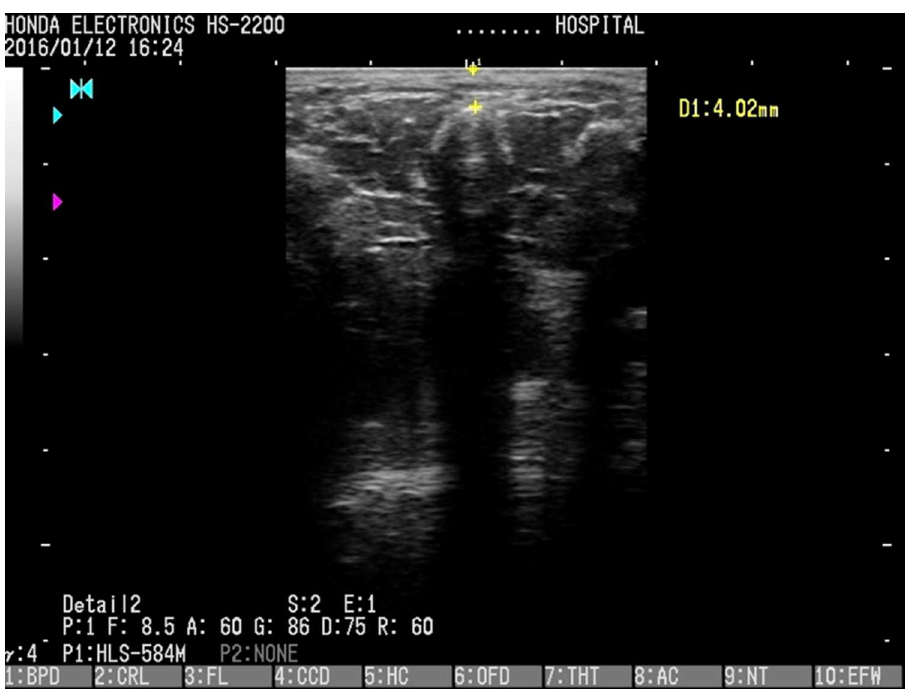
Landmark: From the upper part of the hypodermic fat layer to the upper part of the third